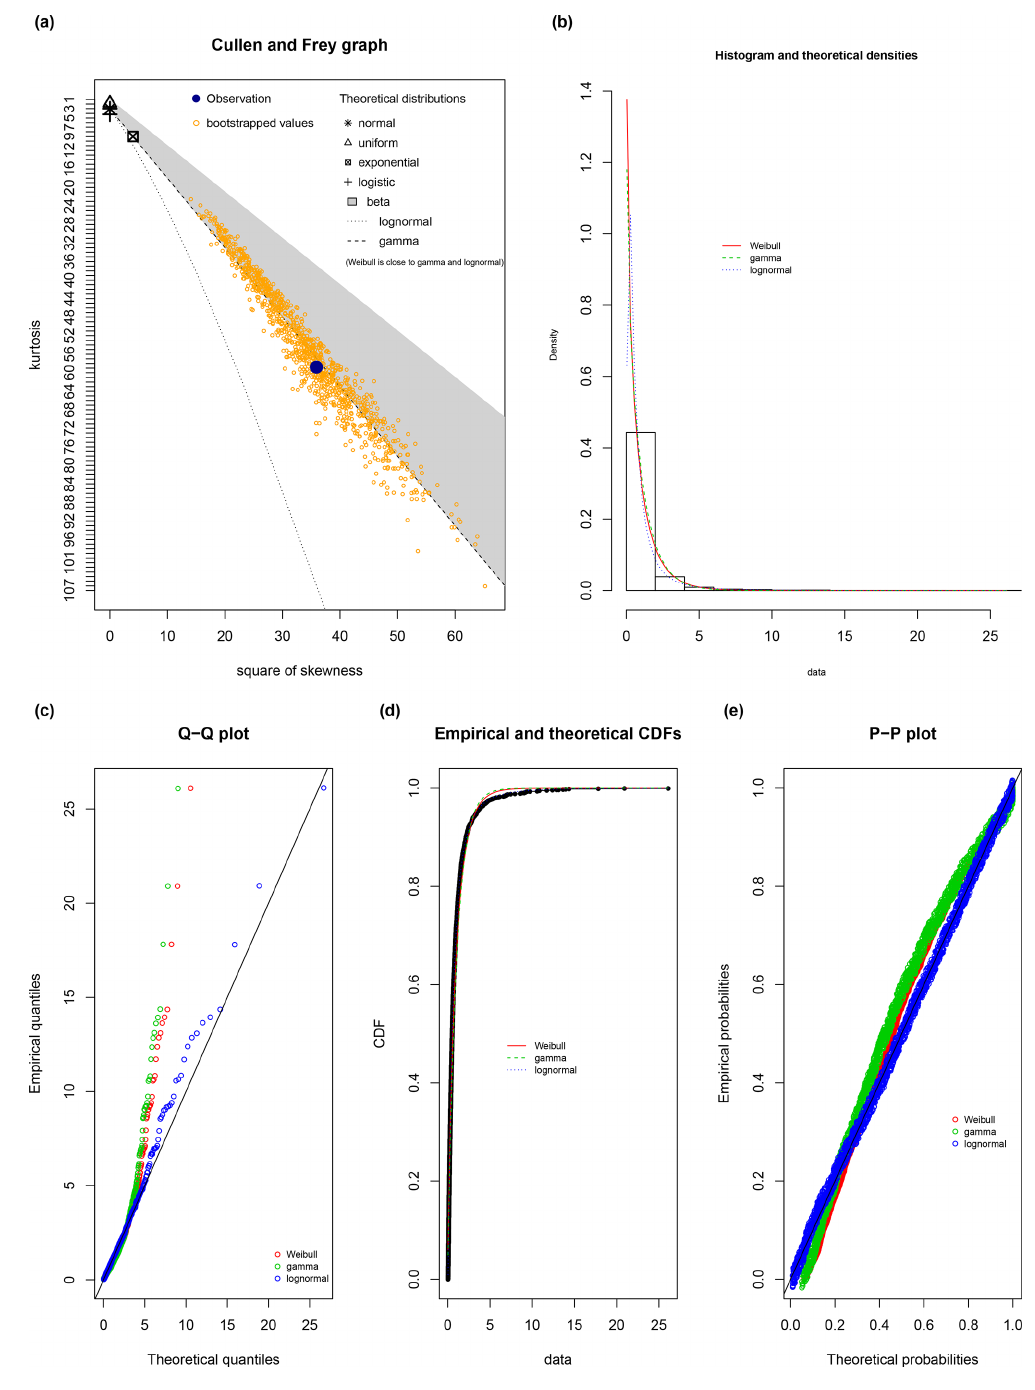
Figure F2. Choice of distribution for lift